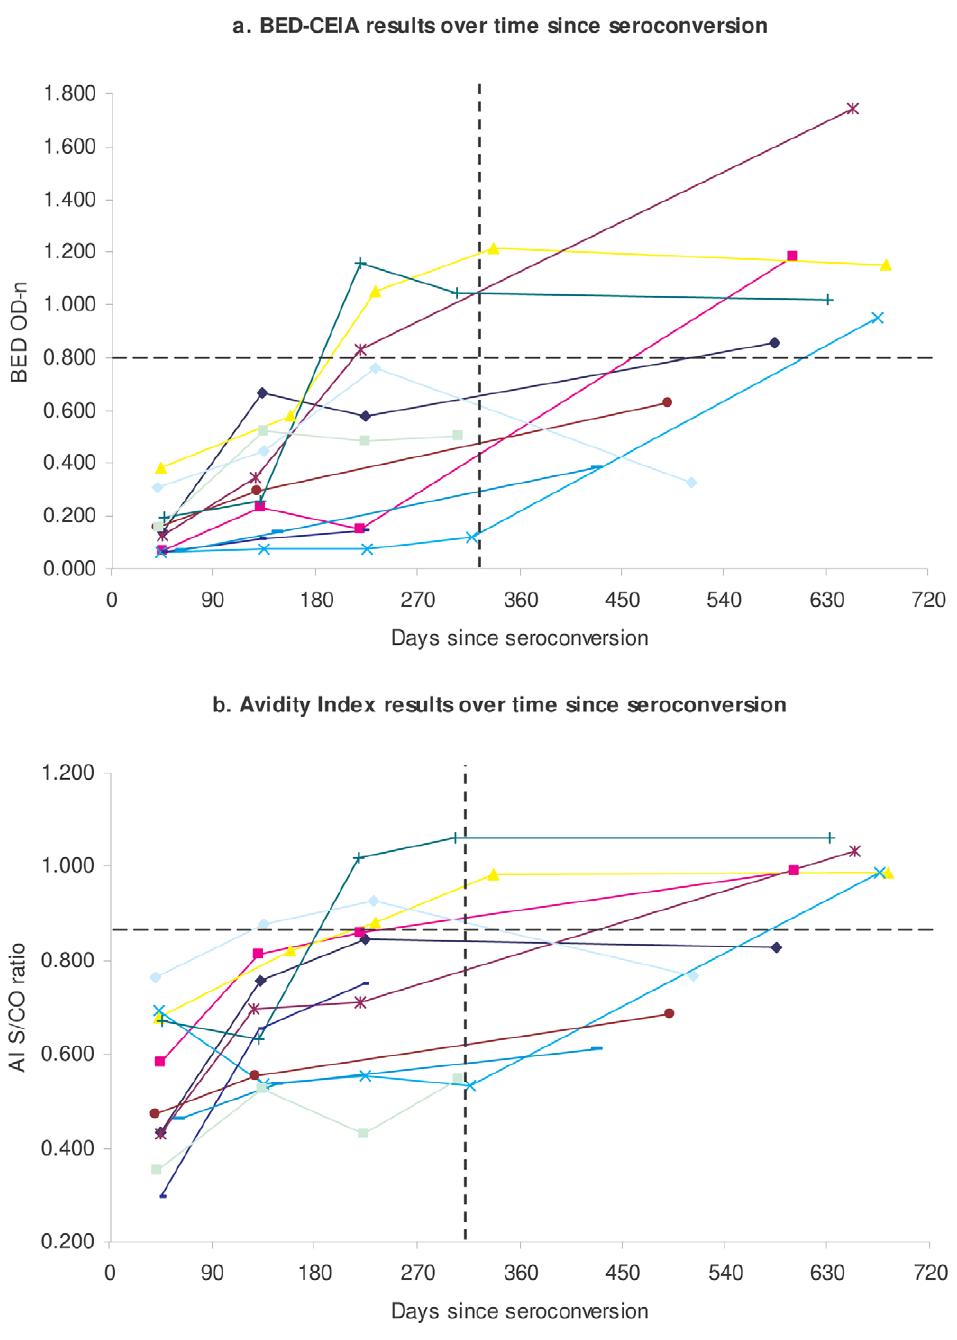
Figure 1. STARHS assay results over time among participants with incident HIV in prospective cohort (N=11).